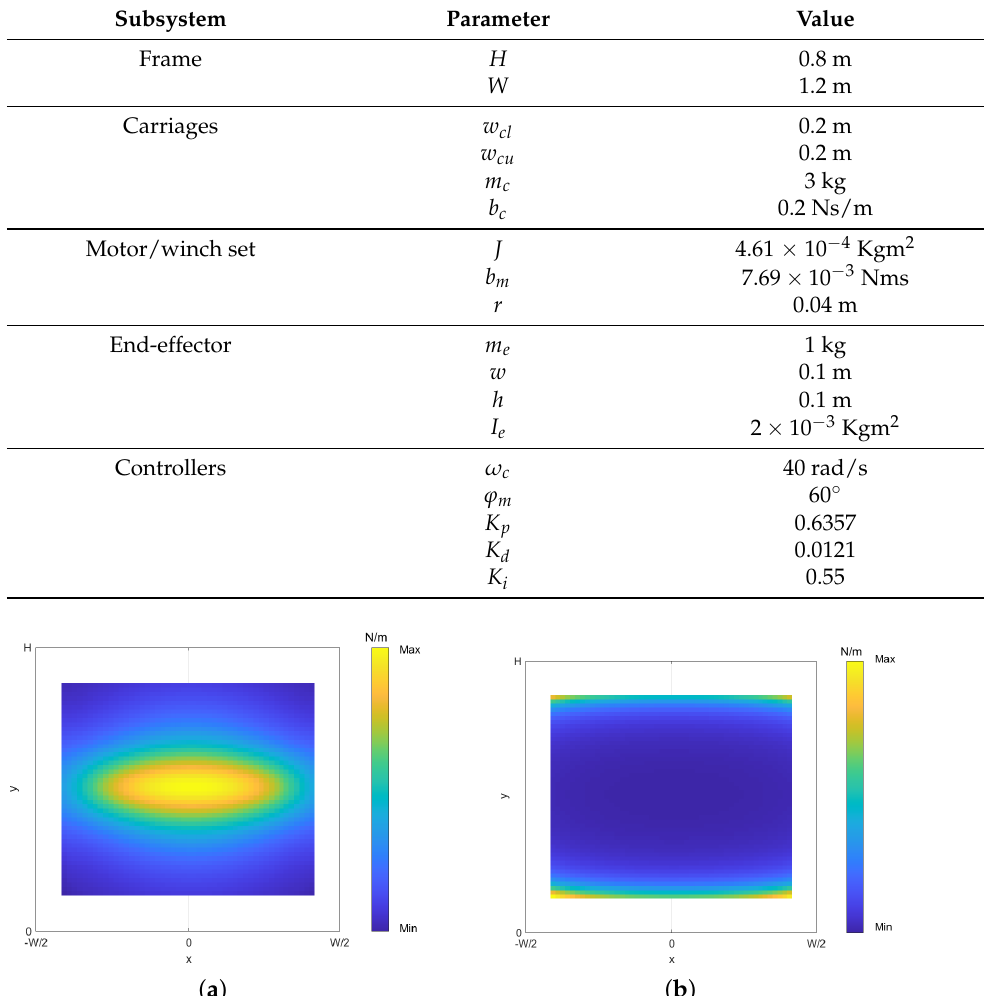
Table 1. Model parameters.